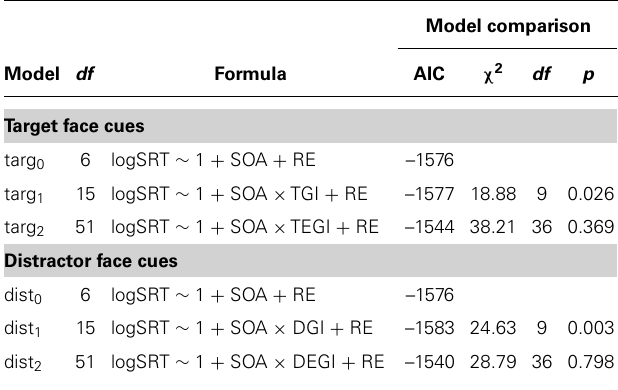
Table 6 | Comparison of nested LMMs fitted to log-transformed SRTs in Experiment